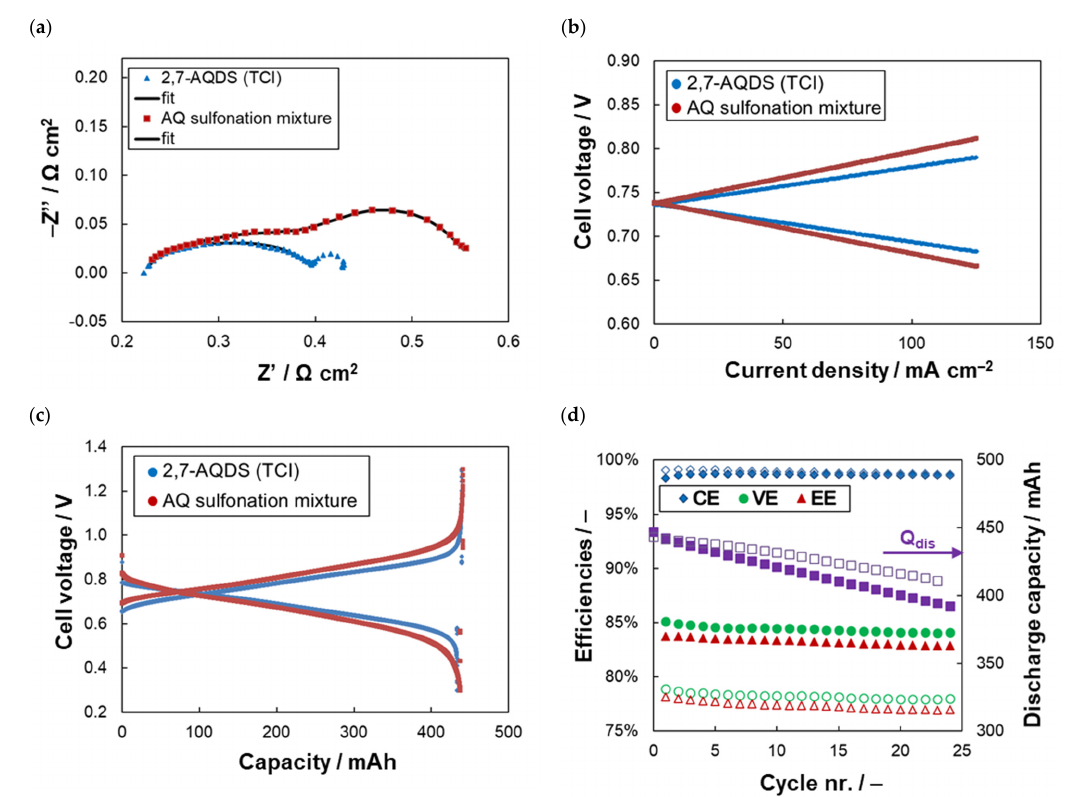
Figure 1. Performance of AQDS-HBr single-cell using two types of anolyte: ( a ) EIS Nyquist spectra of a single-cell in 50% SOC, ( b ) Load curve of single-cell in 50% SoC, ( c ) U-Q dependence of galvanostatic charge-discharge cycle (3rd cycles) at 125 mA cm − 2 ; ( d ) Evolution of battery parameters during the cycling.